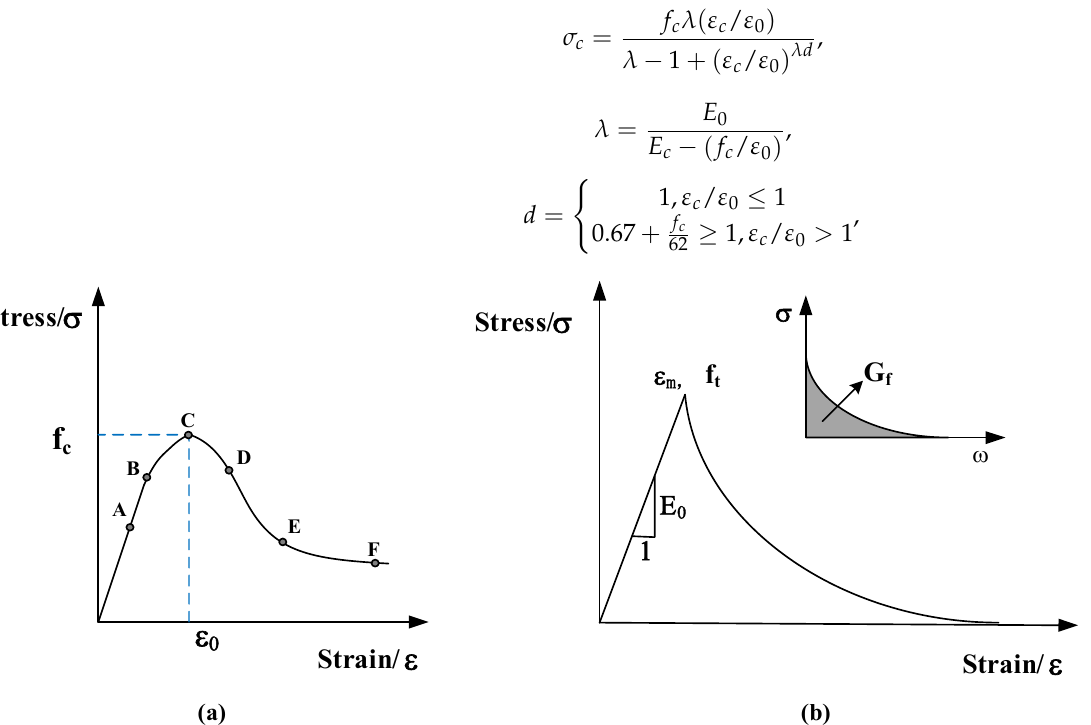
Figure 12. Uniaxial stress–strain curves for PVA rubber/concrete: ( a ) Uniaxial compressive stress– strain curves for PVA rubber/concrete; ( b ) Uniaxial stretch stress–strain curves for PVA rubber/con- crete. Table 6. Parameters of concrete components used in finite element analysis.